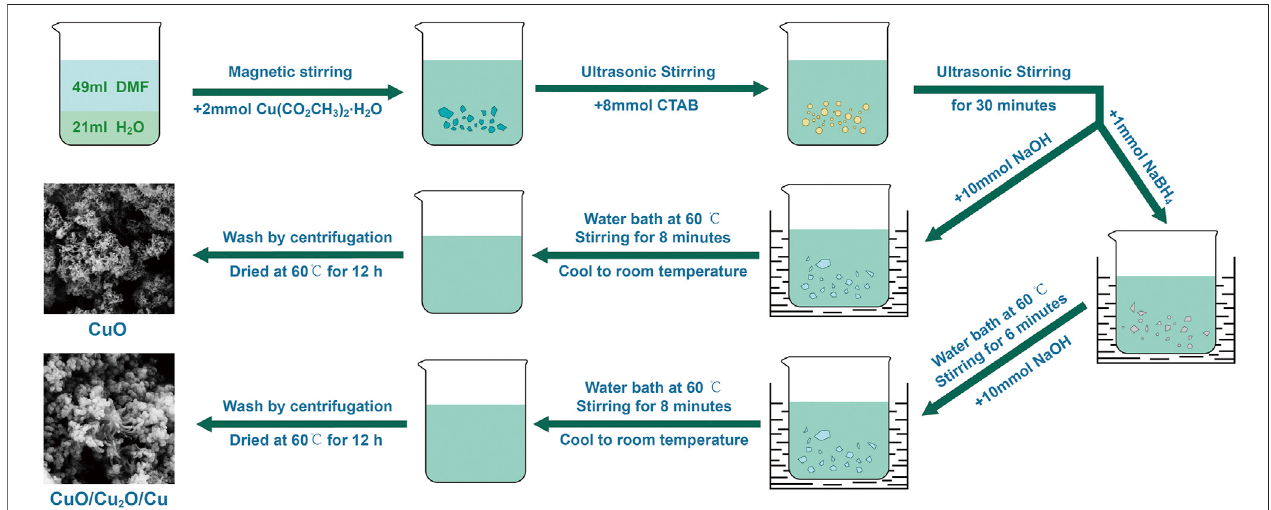
FIGURE 1 | The schematic illustration of preparing CuO nanowires and CuO/Cu 2 O/Cu nanocomposites.